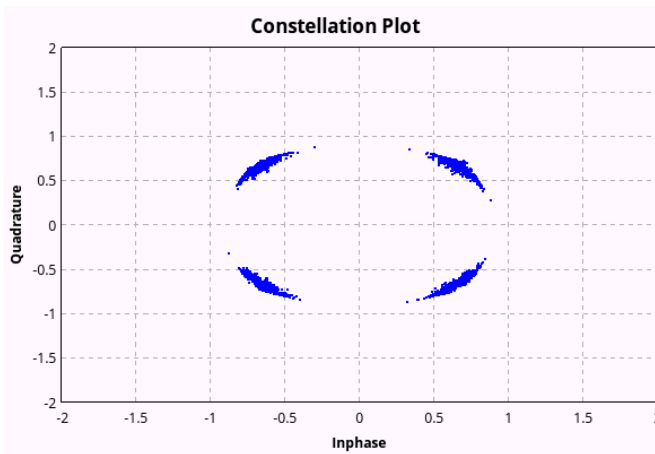
Figure 4. QPSK (quadrature phase shift keying) data transmission results for sub-sea MI (magnetic-induction) wireless